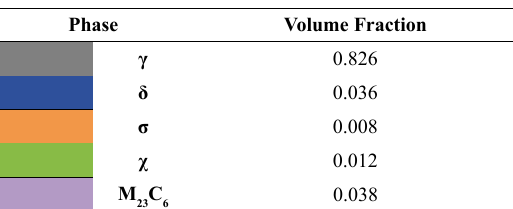
Table 10. Amounts of phases determined by EBSD in the weld metal FSW.